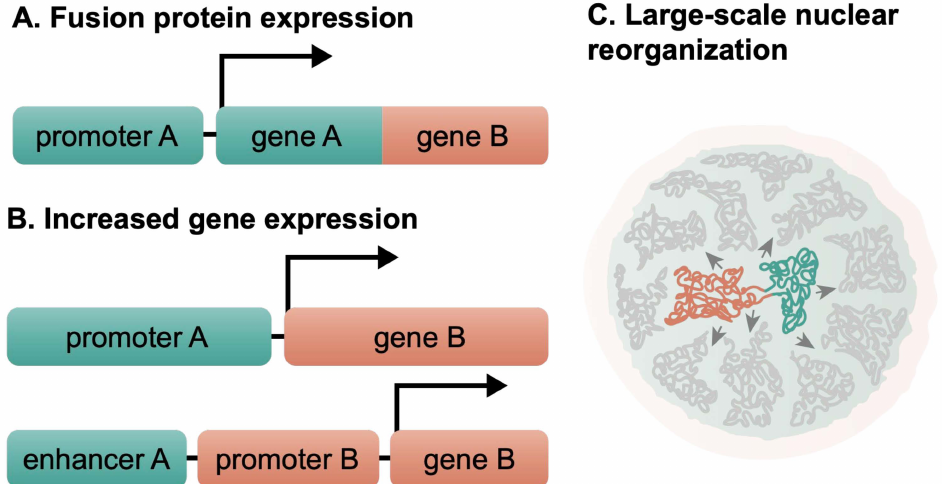
Figure 2. Molecular and functional consequences of chromosomal translocations. Chromosomal translocations can bring about the formation of fusion protein ( A ) or the ( B ) aberrant expression of an otherwise normal gene as well as ( C ) large-scale changes in the nuclear organization have also been attributed to chromosomal